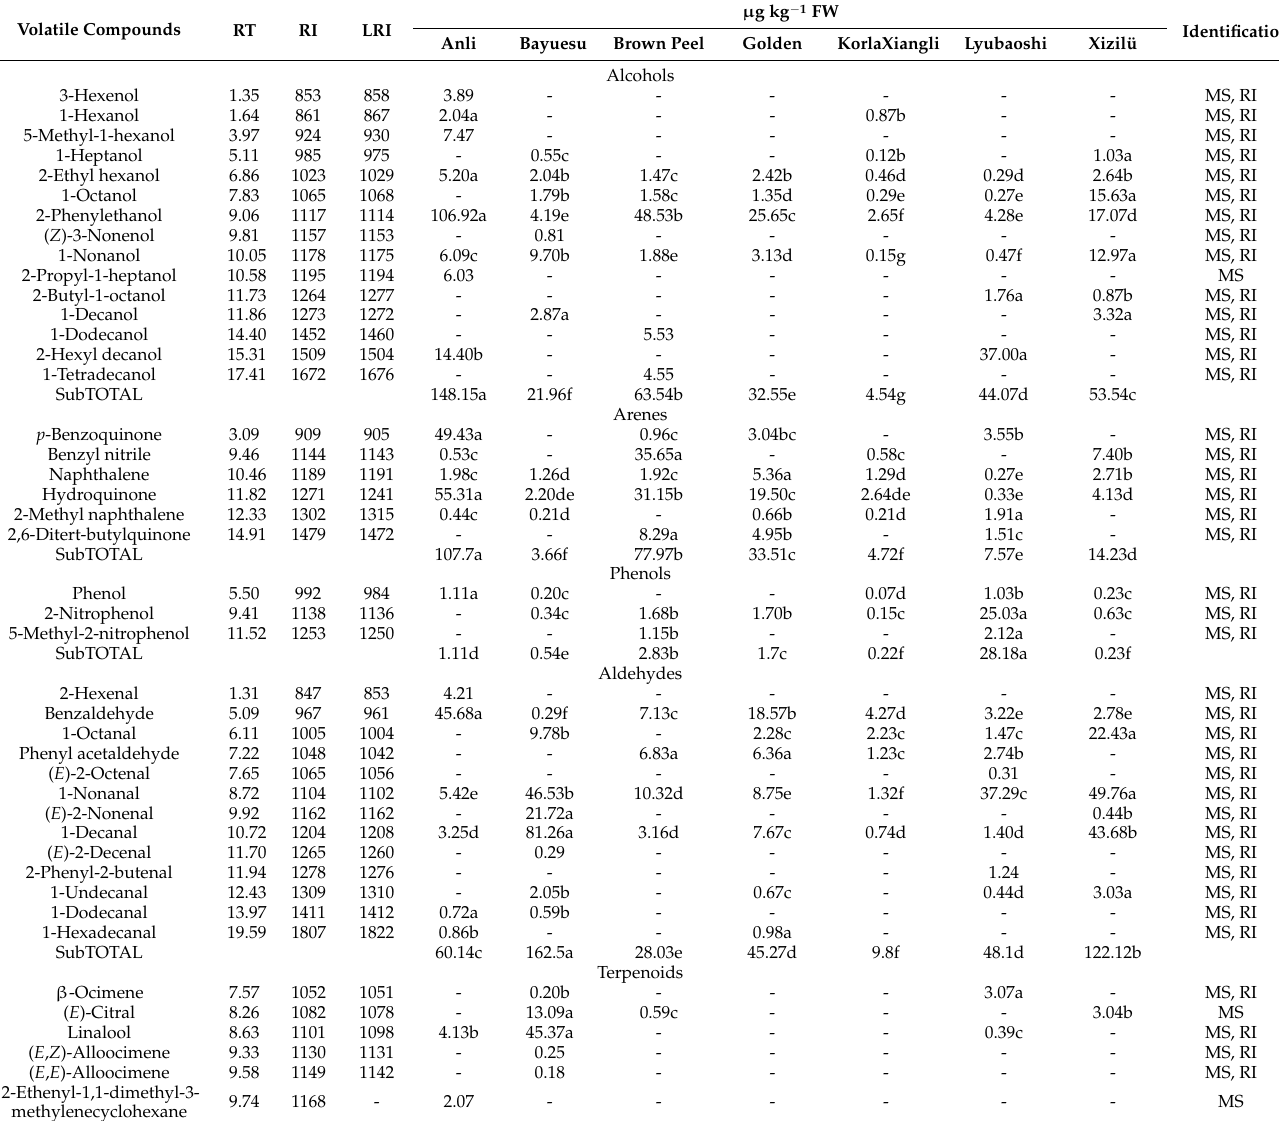
Table 2. The volatile compounds detected in the flower of seven pear cultivars and their semi- quantitative determination ( µ g kg − 1